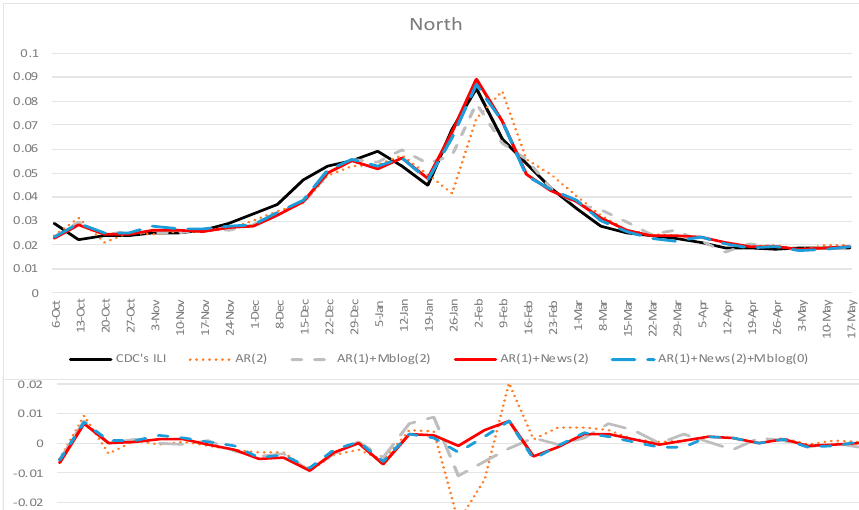
Figure 4. Forecasting results for the north of mainland China, 6 October 2019–17 May 2020. The weekly estimations of AR(2) (dotted orange), AR(1) + Mblog(2) (long dashed gray), AR(1) + News(2) (red), and AR(1) + News(2) + Mblog(1) (dashed blue) models were compared against the CNIC’s ILI rates (black). Bottom: The estimation error, defined as the estimated value minus the CNIC’s ILI